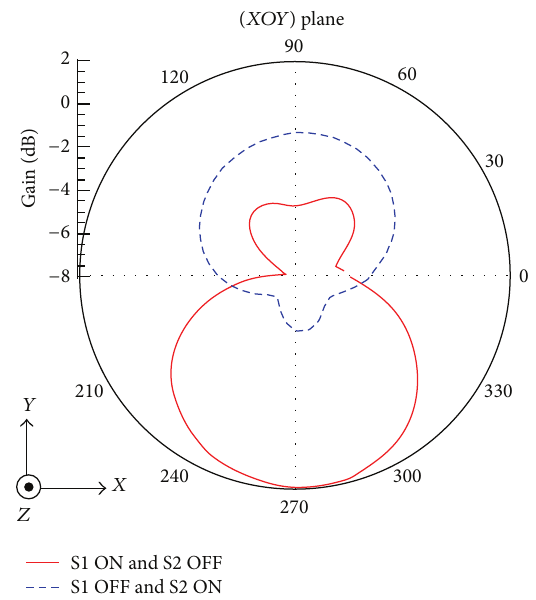
Figure 8: Measured 2D radiation patterns in the ( 𝑋𝑂𝑌 ) plane of the prototype single NFRP element reconfigurable antenna. State 1 (red) at 𝑓 𝑅 = 1.59 GHz and State 2 (blue) at 𝑓 𝑅 = 1.76 GHz.